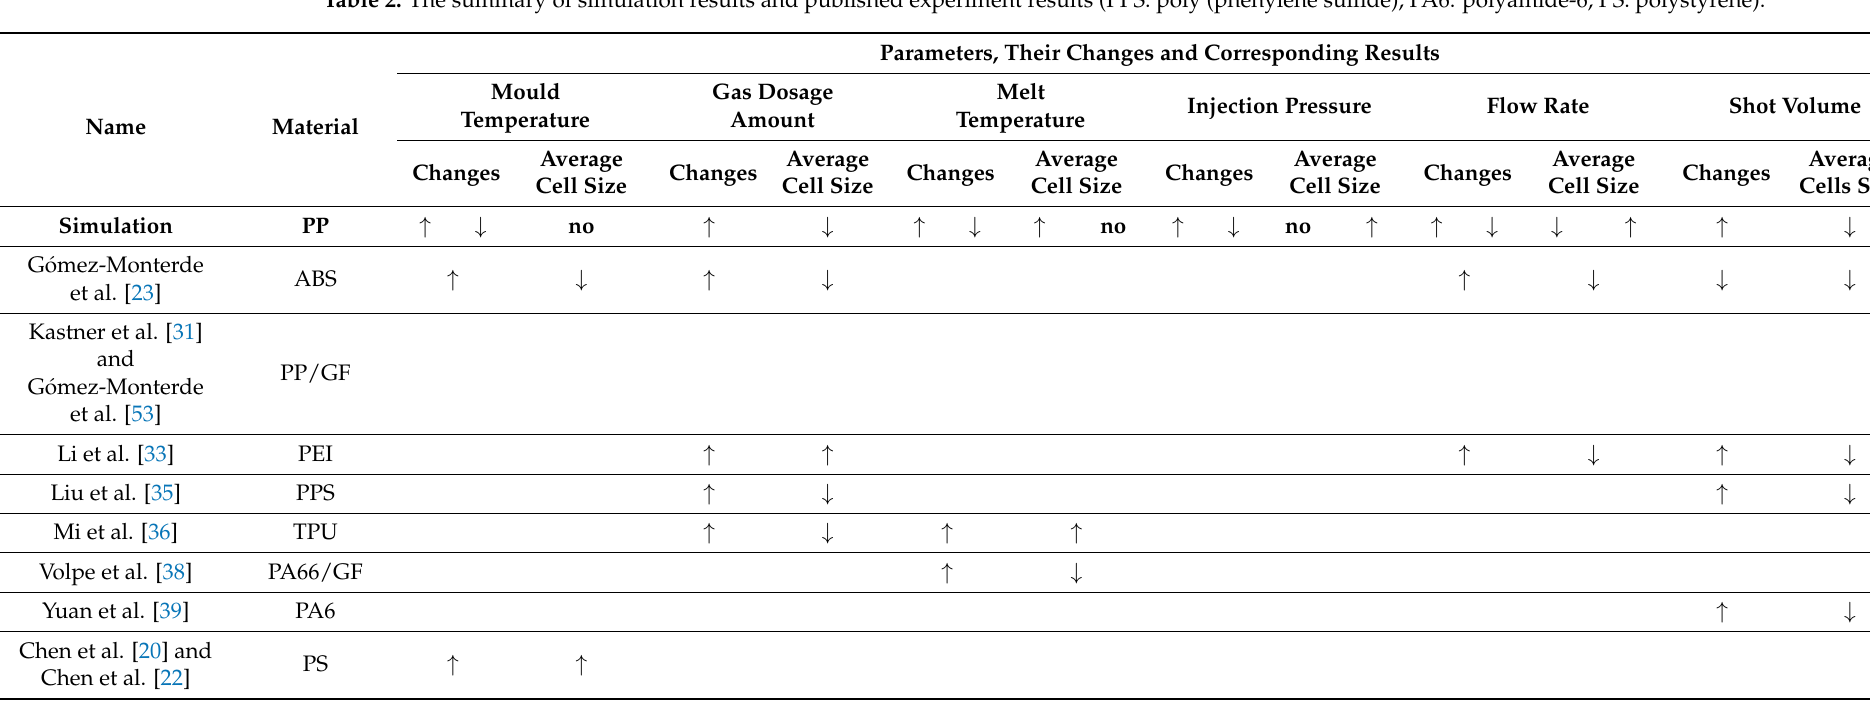
Table 2. The summary of simulation results and published experiment results (PPS: poly (phenylene sulfide), PA6: polyamide-6, PS: